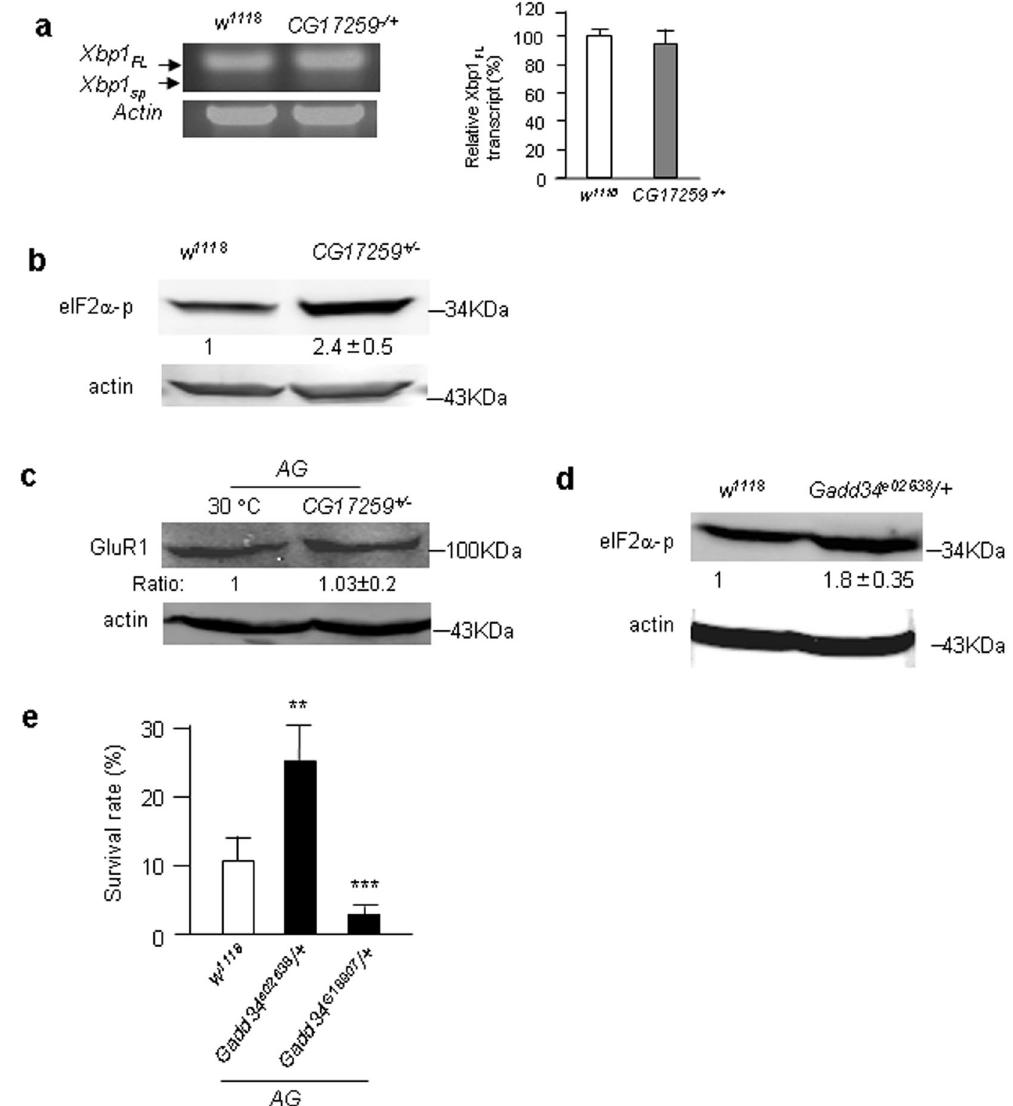
Figure 2. Loss of CG17259 induced eIF2 α phosphorylation. ( a ) The quantitative RT-PCR for Xbp1 FL is shown. The DNA gel with migrations of Xbp1 FL and Xbp1 sp are indicated. Xbp1 sp is not detected. Trial n = 8. ( b ) The Western blot shows the level of phosphorylated form of eIF2 α (eIF2 α -p) in the CG17259 mutant flies. The eIF2 α -p antibody recognizes the S51 phosphorylation site of eIF2a. Actin is shown as the protein loading control. Trial n = 3. The full length gels of all Western blots were shown at the end of the supplementary information. ( c ) The Western blot shows the level of GluR1 Lc in the genotype of flies indicated. Actin is shown as the protein loading control. Trial n = 3. ( d ) The Western blot shows the level of eIF2 α -p in the Gadd34 mutant flies. Actin is shown as the protein loading control. Trial n = 3. ( e ) Survival rate of AG flies was shown with the genotype of flies indicated. Trial n =